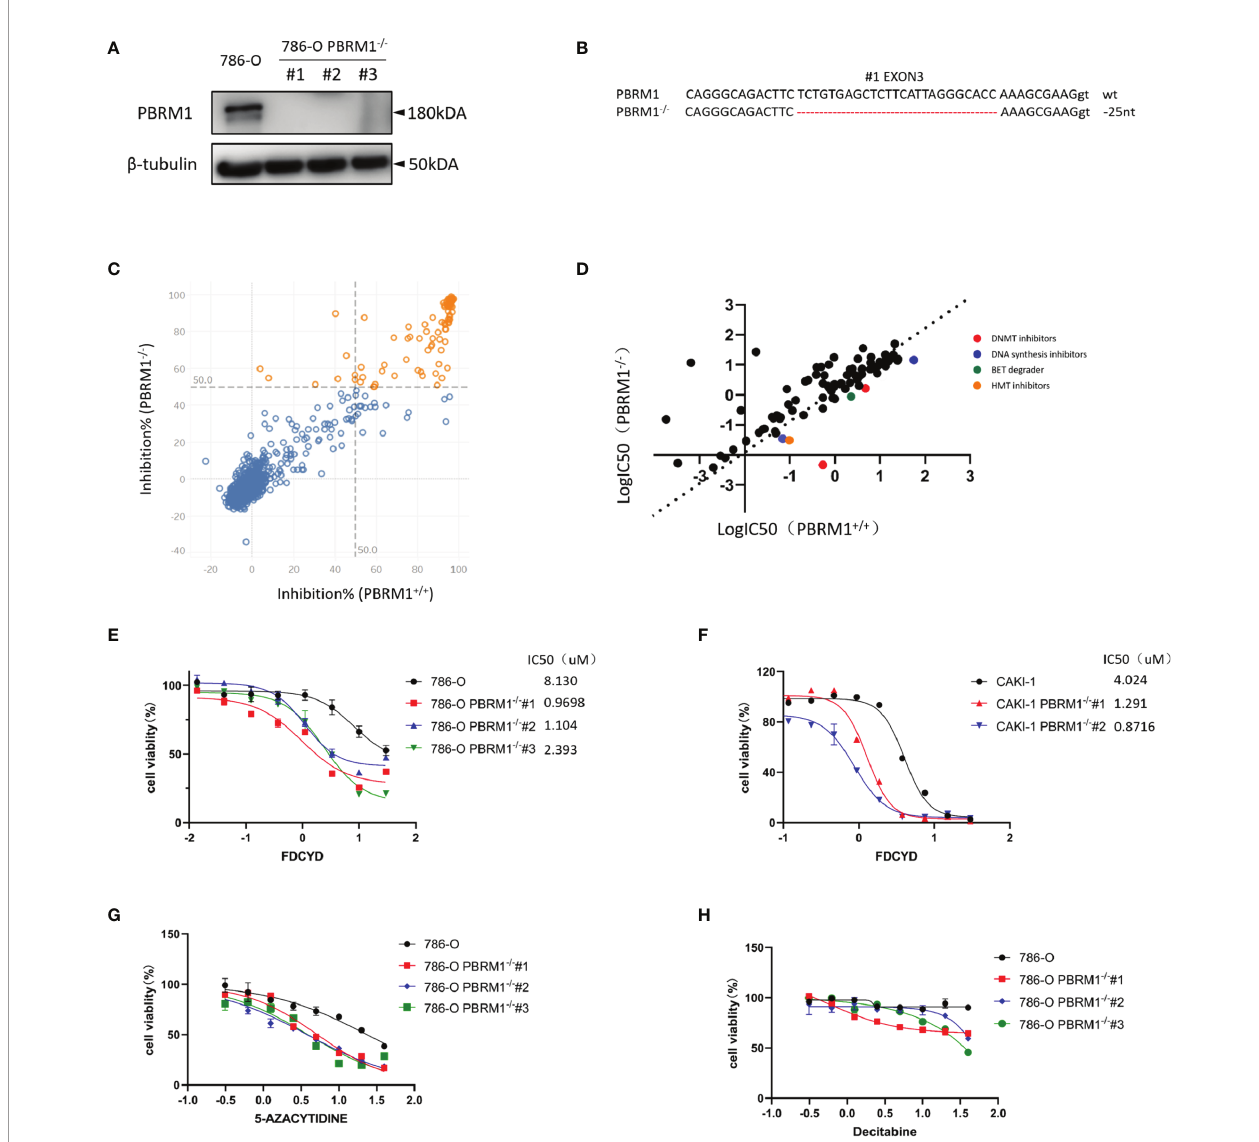
FIGURE 1 | Epigenetic compound library screen identi fi es DNMT inhibitors as synthetic lethal drugs in PBRM1-de fi cient renal cancer cells. (A) Western Blot analysis showing loss of PBRM1 expression in the three PBRM1 − / − clones. (B) The genomic Sanger sequencing of PBRM1 locus in 786-O PBRM1+/+ and PBRM1-/-(#1) cells. PBRM1 − / − clone#1 lost 25 nucleotides in exon 3. (C) A compound inhibition rate plot of the fi rst round screen data are shown. (D) A log10-IC50 plot of the second round screen data are shown. The IC50 values of the compounds against 786-O PBRM1+/+ and PBRM1-/- cells was plotted. Compounds with selectivity index (SI) > 2 for PBRM1 − / − cells were chosen as synthetic lethality candidates. (E – H) Cell viability assay was done to certify the synthetic lethality effect by Fdcyd in 786-O isogenic pairs (E) and CAKI-1 isogenic pairs (F) . The other two DNMTis 5-Azacytidine (G) and Decitabine (H) were also used to test the IC50 in 786-O isogenic pairs. Error bars represent s.d. (n = 9) from three independent experiments. ANOVA P value of <0.001 for Fdcyd, 5-Azacytidine and